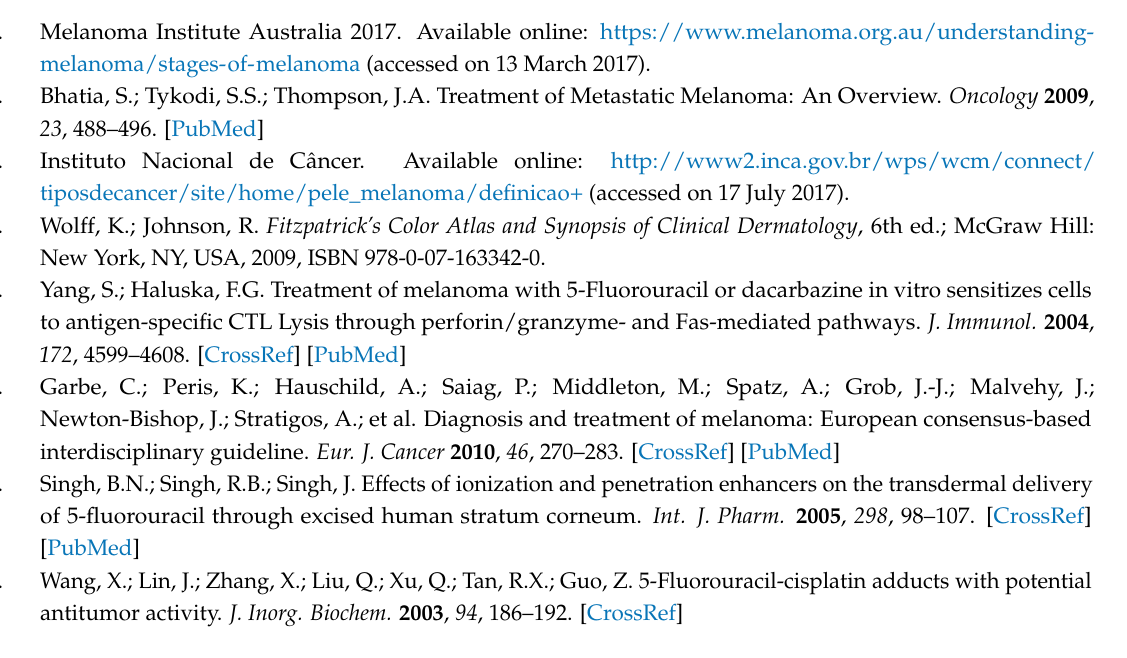
Table S1. Mitochondrial activity evaluation of human melanoma cell lines against the 5-fluorouracil-loaded micro and nanoparticles at different concentrations and exposition